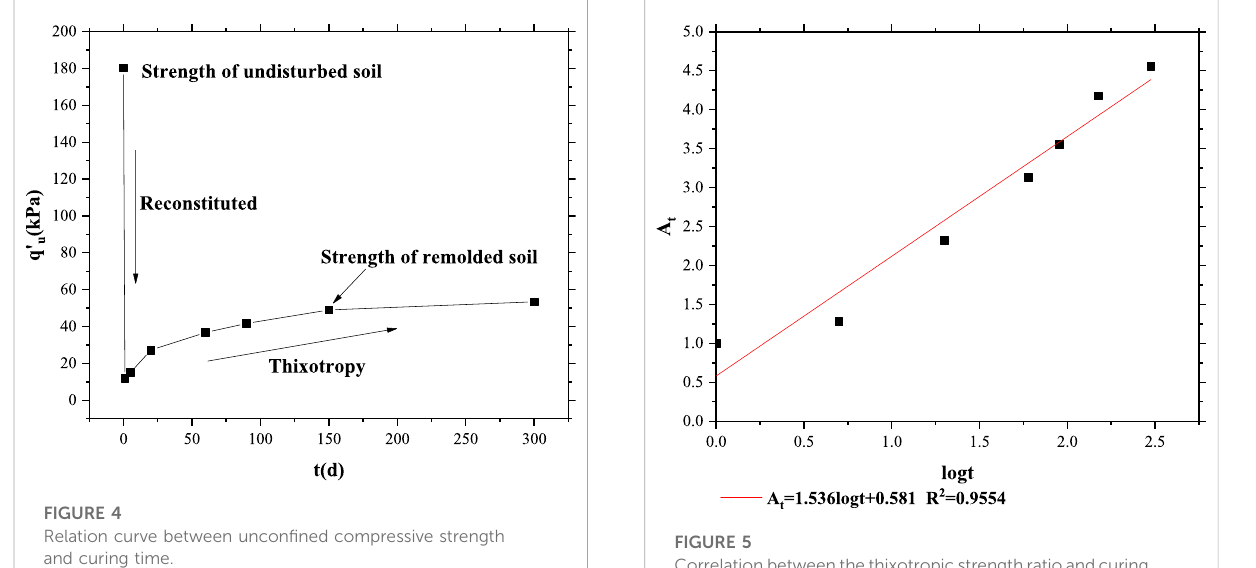
FIGURE 4 Relation curve between uncon fi ned compressive strength and curing time.